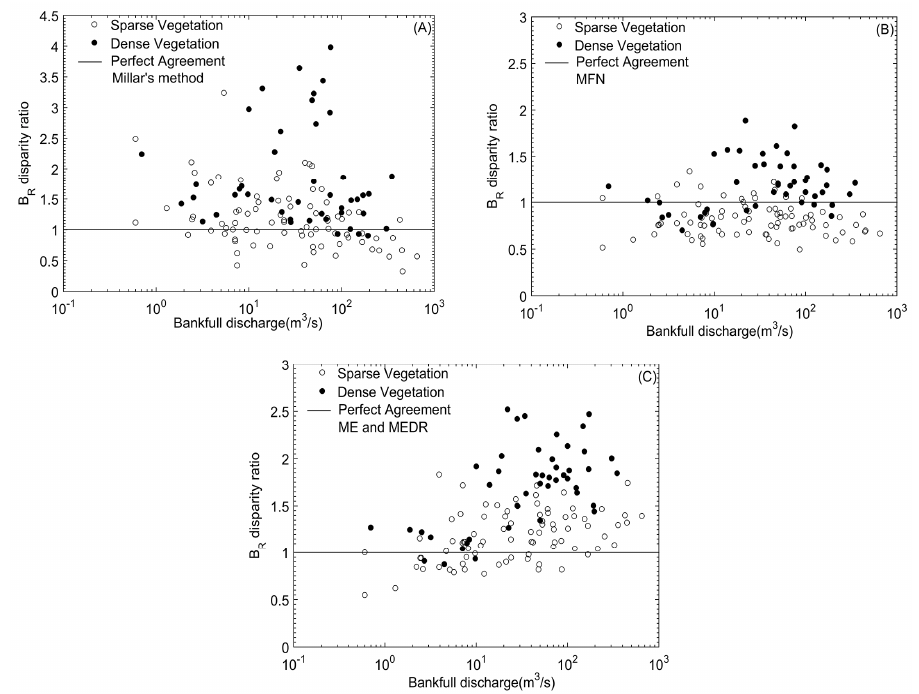
Figure 9. Scatter plot of disparity ratio B R against bankfull discharge for gravel bed channels [2,17,48,49]. ( A ) Millar’s Method; ( B ) MFN; ( C ) ME and MEDR.